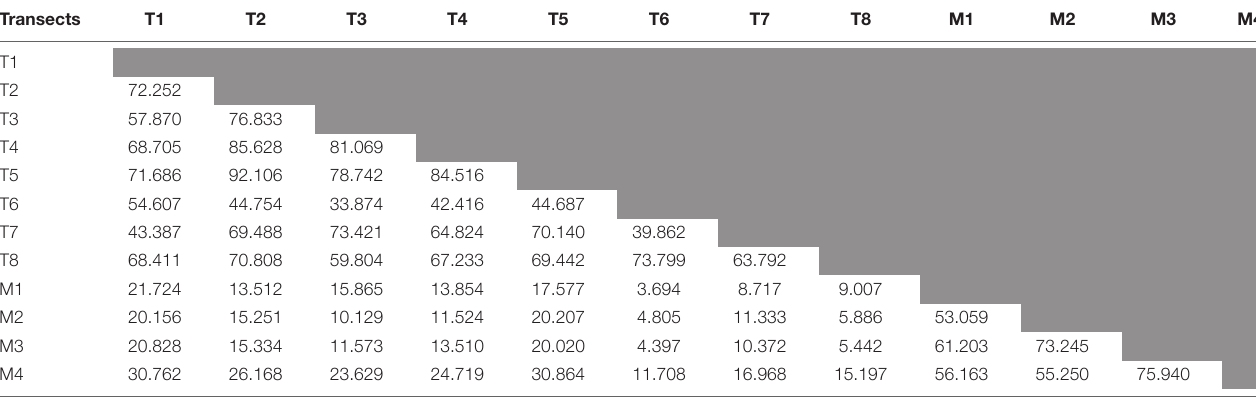
TABLE 1 | Bray-Curtis similarity analysis for all transects at both sites.